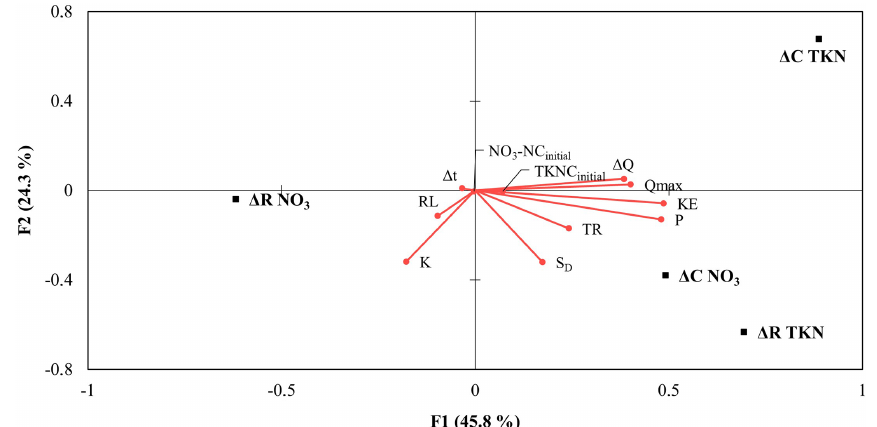
Figure 7. Redundancy analysis distance biplot showing ordinations of explanatory and response variables. The response variables